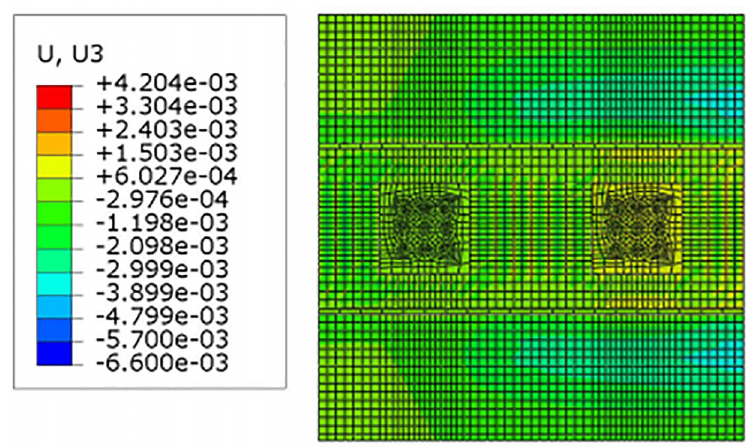
selected node gradually decreases, the minimum settlement value of the soil near the bridge center. The maximum settlement value of the surface node continues to decrease at 20 m com- pared with 10 m, but the decrease is also relatively smaller than that at 5 m~10 m. The law of surface deformation can be obtained preliminarily. At the same surface section position, as the jacking distance increases, the maximum settlement value above the two pipes gradually decreases, and the minimum settlement value of the soil near the bridge pier gradually decreases until there is slight uplift, while the central soil gradually settles.